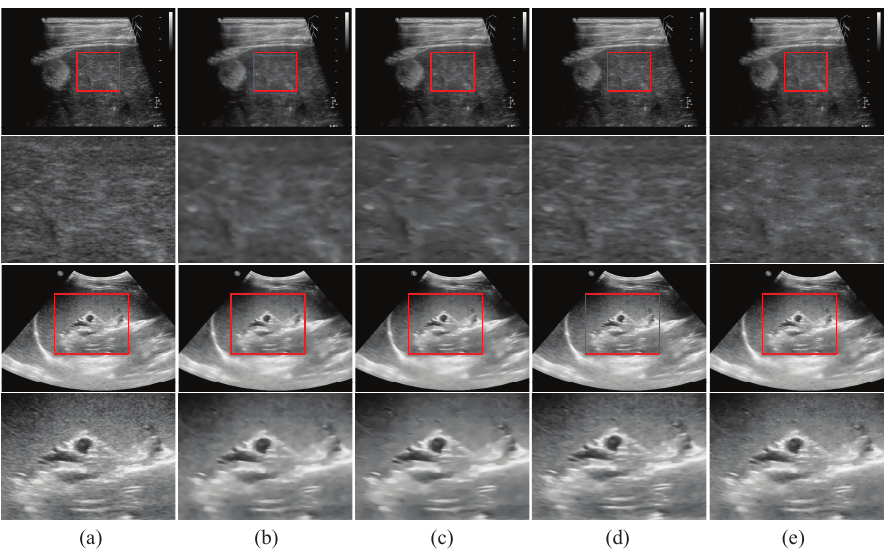
Figure 7. Comparison of despeckling results on the liver and spleen ultrasound images. ( a ) The original liver and spleen ultrasound images and the results by ( b ) bilateral filter [6], ( c ) OBNLM [29], ( d ) the method of Zhu et al. [14], and ( e ) the proposed method. The first and third rows list the full-size images, and the second and fourth rows show the zoomed-in patches containing the regions of interest (ROIs), marked by the red rectangles in the whole